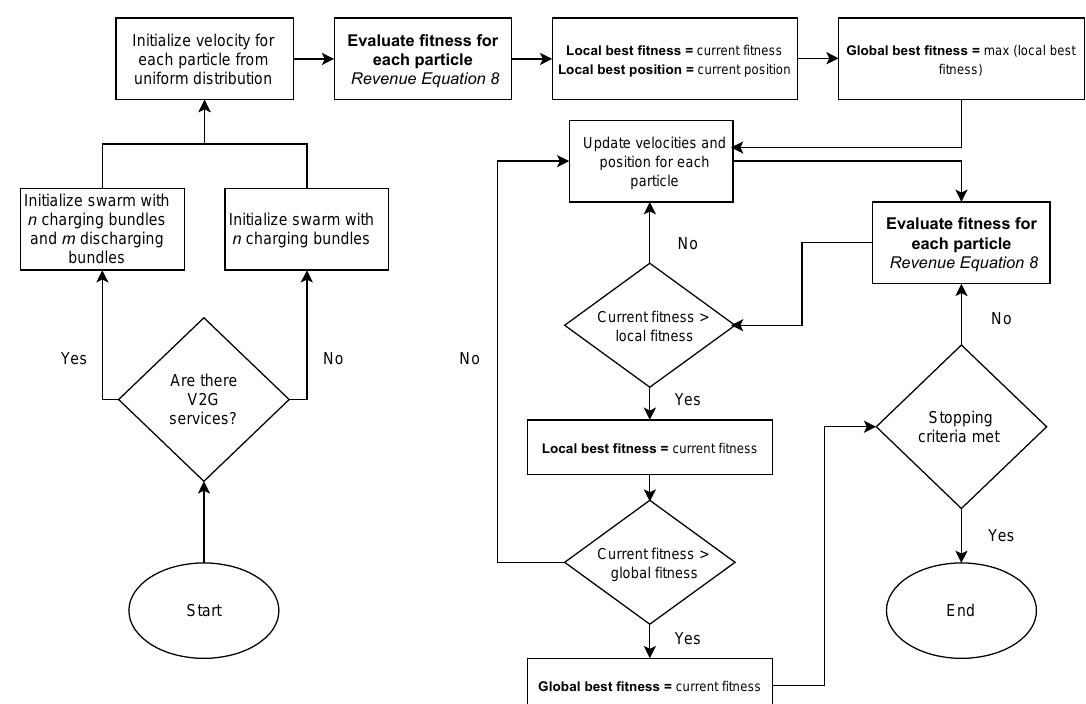
Figure 6. Particle Swarm Optimization (PSO) solution for price optimization.